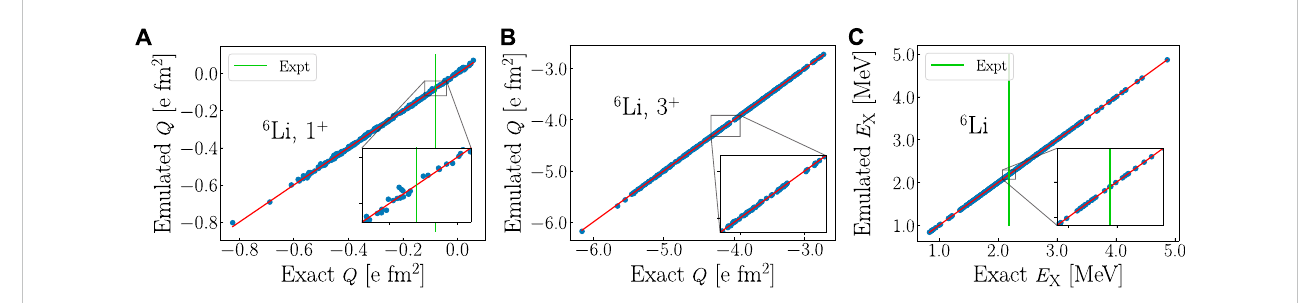
FIGURE 5 Exactvs.SA-EVCobservablesin 6 Li(bluecircles)forthequadrupolemoment Q of (A) the1 + groundstateand (B) the fi rstexcited3 + state,aswellas (C) for theexcitationenergy E X ofthe3 + state,in 〈 2 All 〉 8 13 SAmodelspacesandfor Z Ω =15 MeV.Alsoshownistheagreementbetweentheexactandemulatedvalues to guide the eye (red line), and experimental results (vertical green line) where available. Insets show 5%-regions surrounding reported experimental data [45] or the NNLO opt result where data is not available [a 50%-region is used for the very small Q in (A) ].